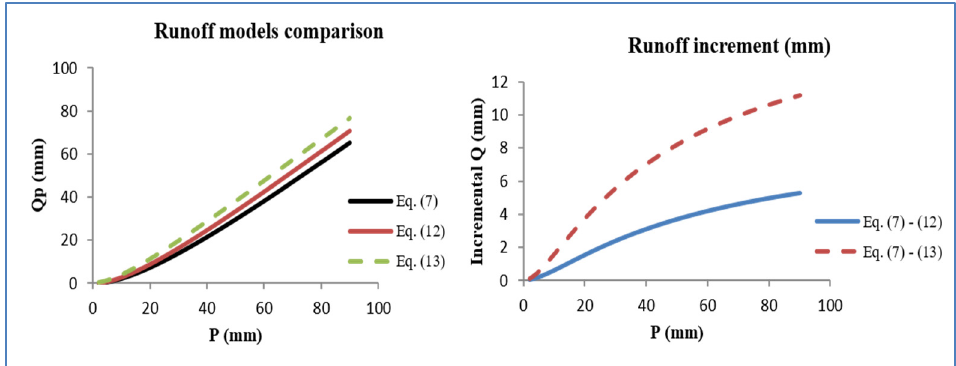
Figure 3. Runoff models using all P-Q data (Equation (7)), Q/P > 50% (Equation (12)), Q/P > 60% (Equation (13)) and runoff depth (mm) increment at Sungai Kayu Ara watershed. By comparing Equations (7) and (13), CN 0.2 increased 3.4% with an average of 44% (nearly 178,000 m 3 ) runoff amount increment while CN 0.2 increased 1.7% from Equations (12) and (13) with an average increment of 15.7% (about 75,000 m 3 ) in runoff amount. Note: Runoff depth increment of 1 mm = 22,330 m 3 runoff volume increase at the study site.